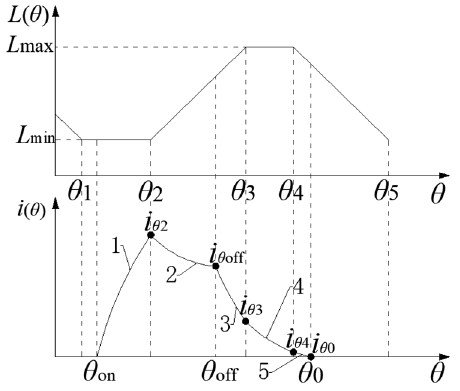
Figure 1. SRM linear inductance and APC control current curve.